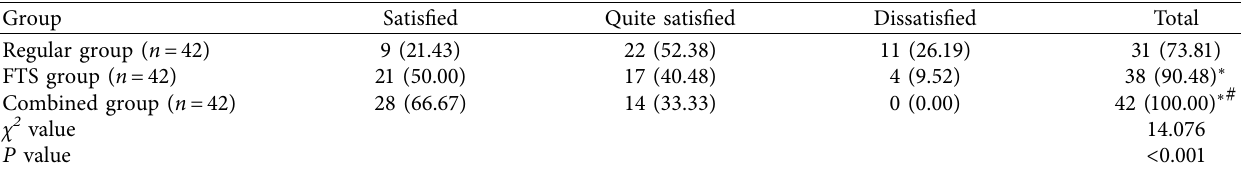
Table 3: Comparison of nursing satisfaction among the three groups ( n ,